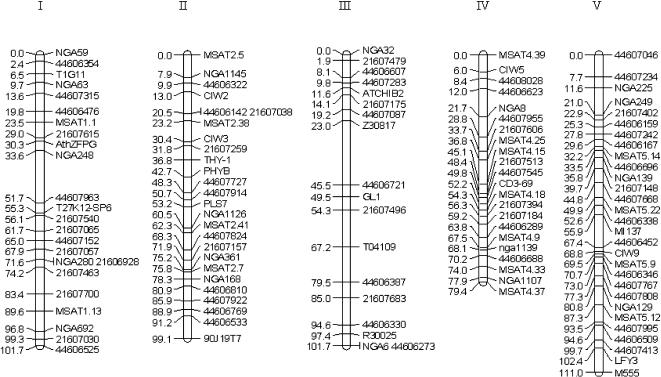
Genetic map of the Kas-1×Col-gl1 RIL population. Distances are in centimorgans using the Kosambi map function. Data for the 55 markers from Wolyn et al. (2004) were merged with 64 SNP markers.